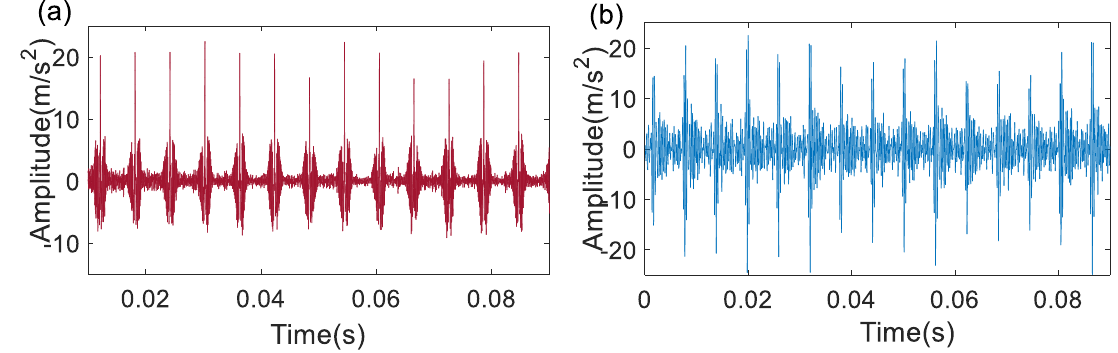
Figure 6. Signals of an NU306 bearing with outer ring fault: ( a ) the simulated signal; ( b ) the experiment signal.